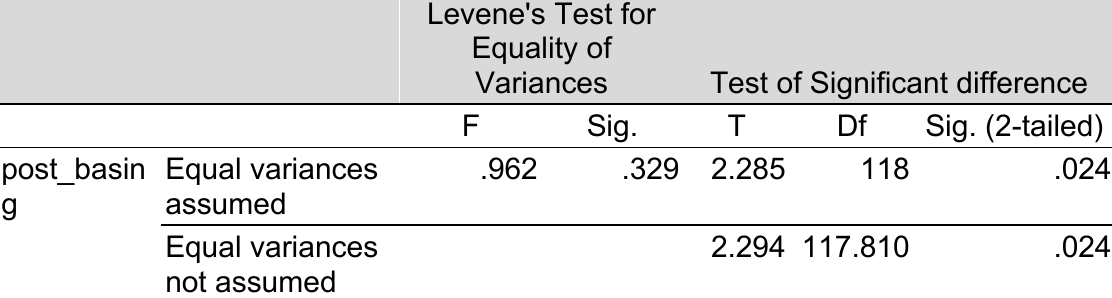
Table 6. Significance of student’ learning outcome in post-test